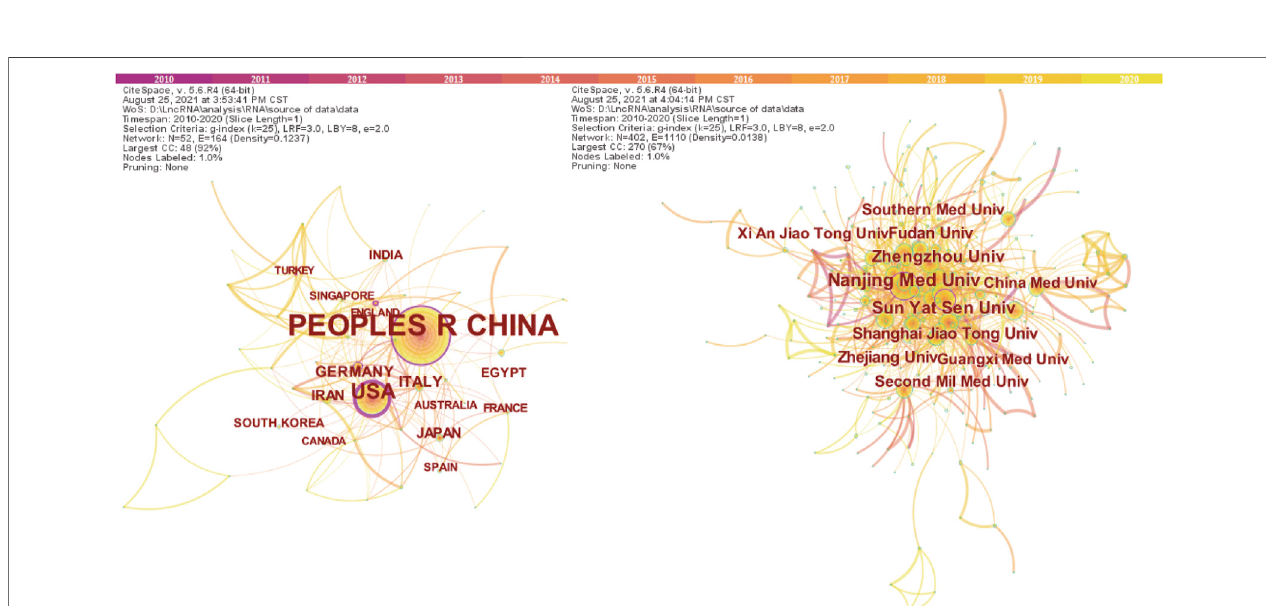
FIGURE 2 | The co-occurrence map of countries (A) (T ≥ 13) and institutions (B) (T ≥ 62) in the fi eld of lncRNAs in HCC development research.